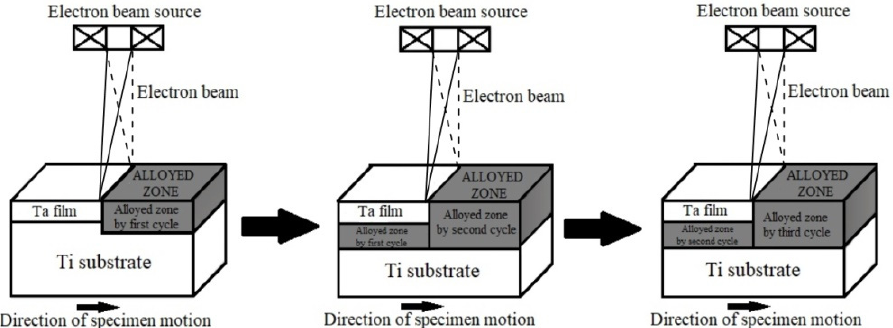
Figure 1. Schematics of the electron-beam cycling additive technique.